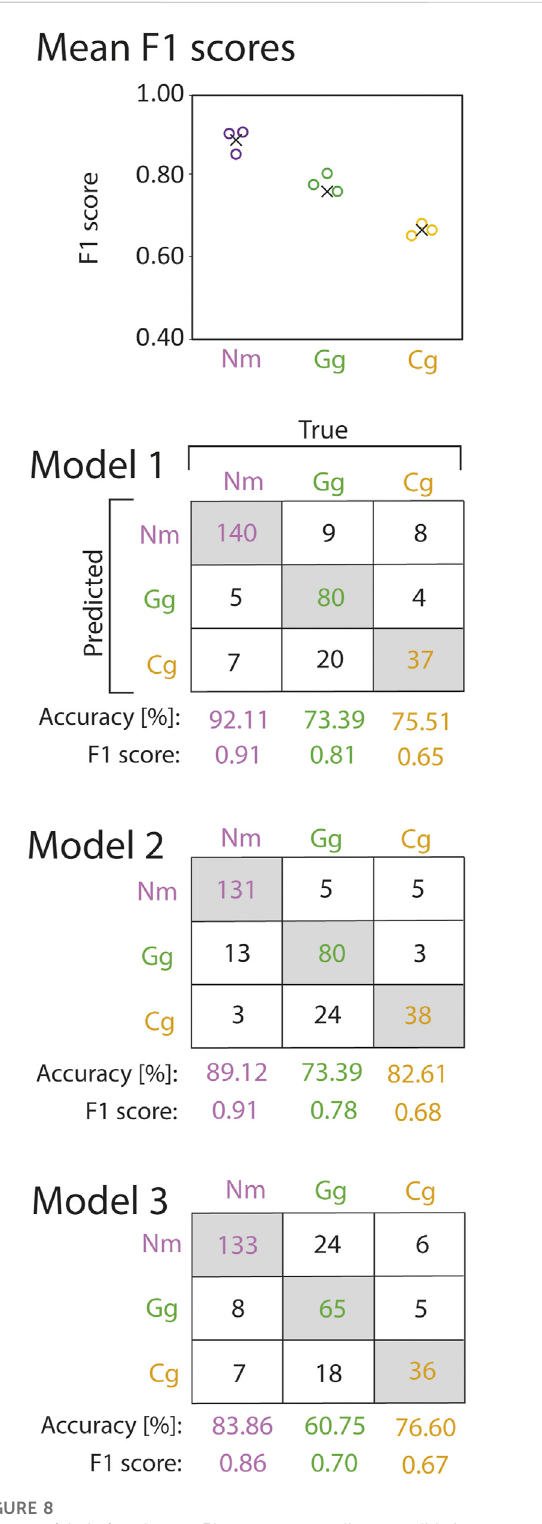
FIGURE 8 F1 scores (circles) and mean F1 scores across all cross validation models(crosses)ofroundgoby(Nm),gudgeon(Gg),andbullhead(Cg) species prediction from the convolutional neural network cross validation (top). Corresponding confusion matrices are provided below. Numbers in the grey shaded boxes represent the number of correctly predicted trajectories for the corresponding fi sh species. Numbers in white boxes represent false